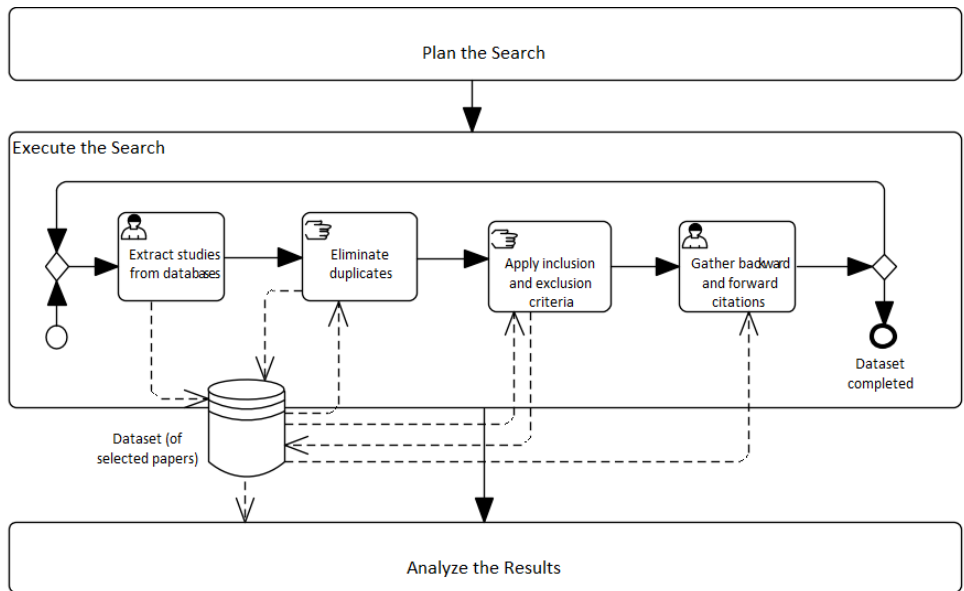
Figure 1. The overall process of SLR (in BPMN notation).